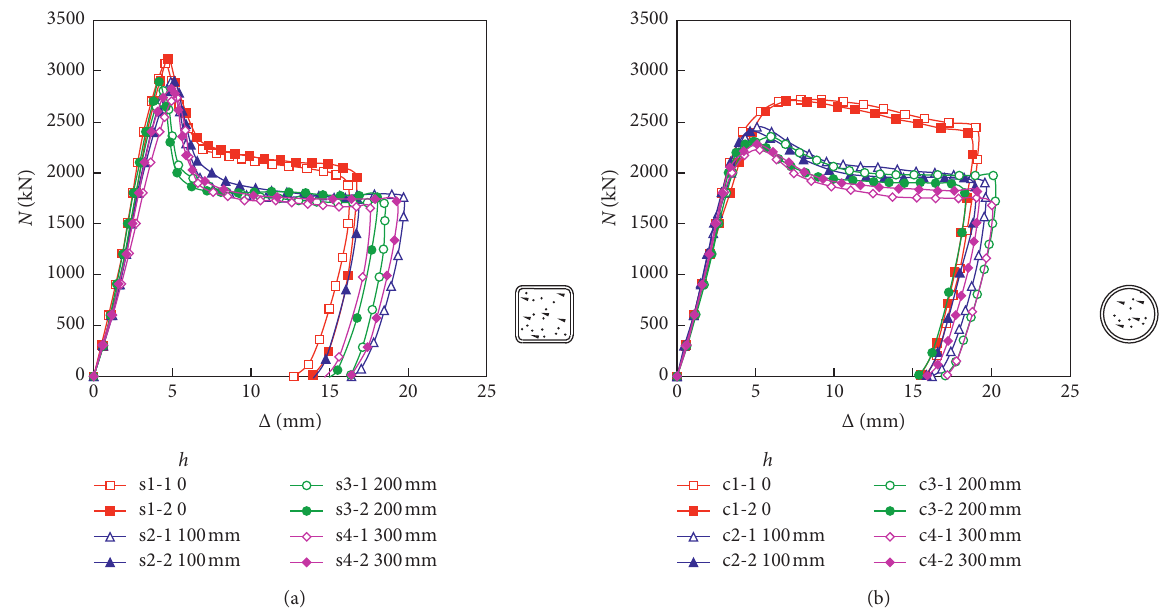
Figure 6: Effects of holes height on load (N) versus deformation ( Δ ) diagrams. (a) Square section. (b) Circular